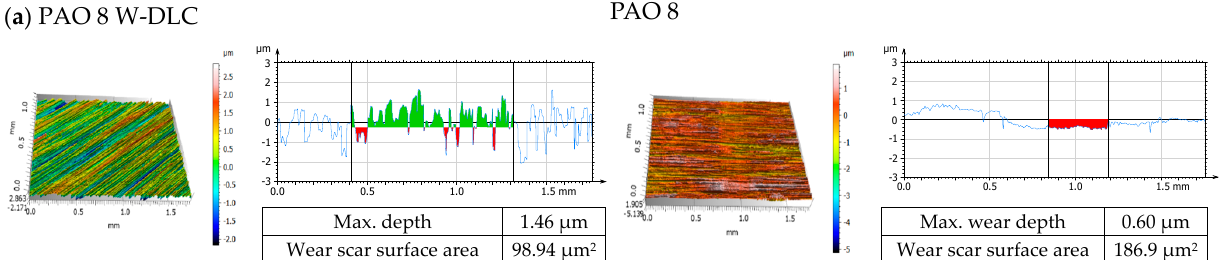
Figure 4. Surface topography: ( a ) the W-DLC coated HS6-5-2C steel disc, ( b ) the uncoated HS6-5-2C steel disc and ( c ) the 100Cr6 steel ball, before the tribological tests.